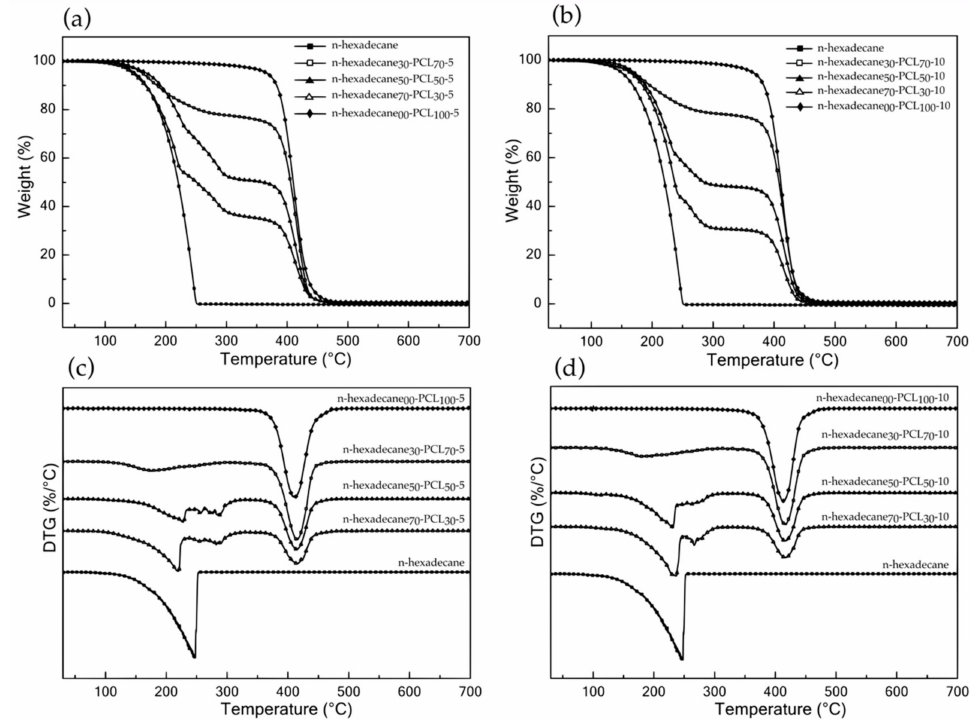
Figure 5. TG and DTG curves of raw n-hexadecane and n-hexadecaneX-PCLY-5 w / v % ( a , c ) and